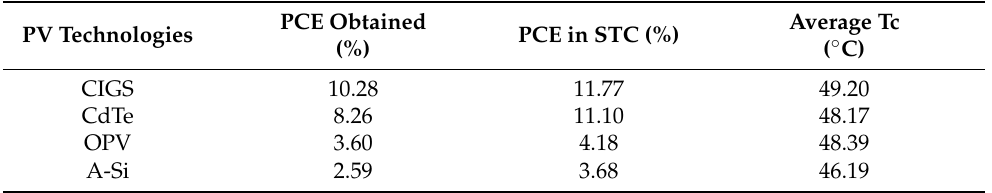
Table 5. Daily average PCE obtained for the PV technologies.